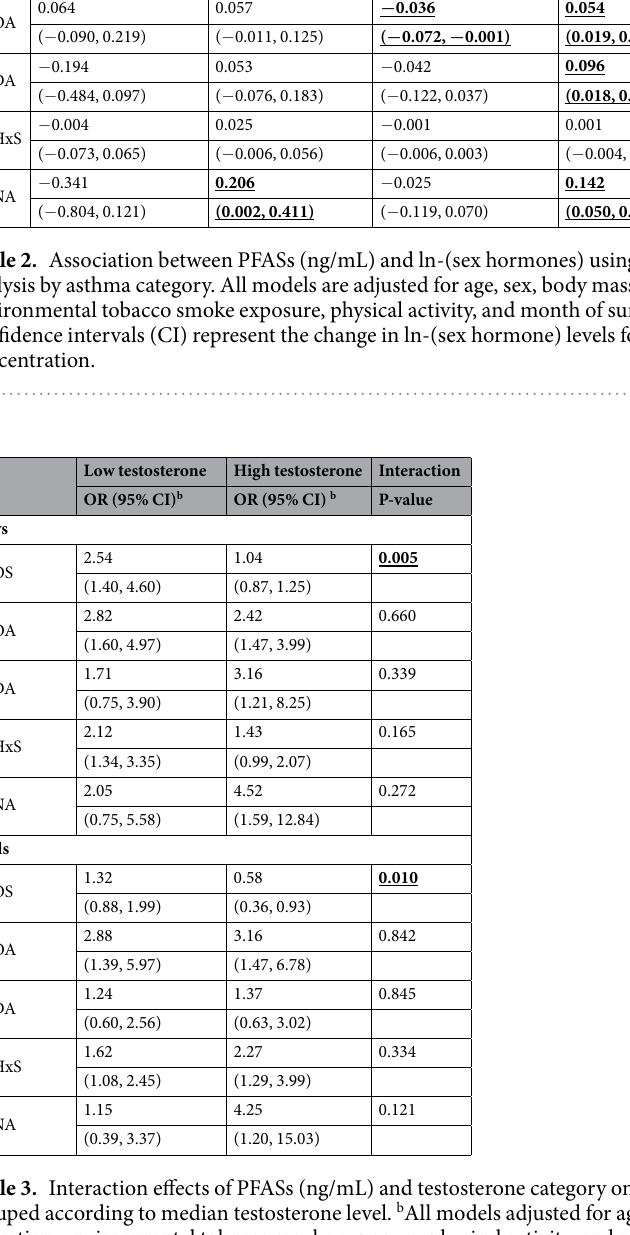
For the association between PFASs and asthma, experimental research has reported a potential positive asso- ciation. In a murine model of asthma, Fairley et al . reported a dose-response relationship between PFOA concen- tration and the OVA-specific airway hyper reactivity response, as well as a pleiotropic cell response characterized by eosinophilia and mucin production 2 . Another in vitro experiment showed PFOA increased both histamine release and expression of pro-inflammatory cytokines, which induce mast cell-derived allergic inflammatory reactions 3 . In addition, one of our own previous studies showed PFOS exposure increased IL-4 and IL-10 but decreased IL-2 and IFN- γ secretion, meaning hosts’ immunity favors a T(H)2-like state 1, 12 . Evidence from epidemiologic studies also supports associations between environmental PFASs and asthma among adolescents. In a cross-sectional study of 566 community-dwelling participants with prolonged PFOA exposure through contaminated drinking water, Anderson-Mahoney et al . found an association between PFOA exposure and asthma 4 . Specifically, asthma prevalence increased among participants exposed to PFOA compared